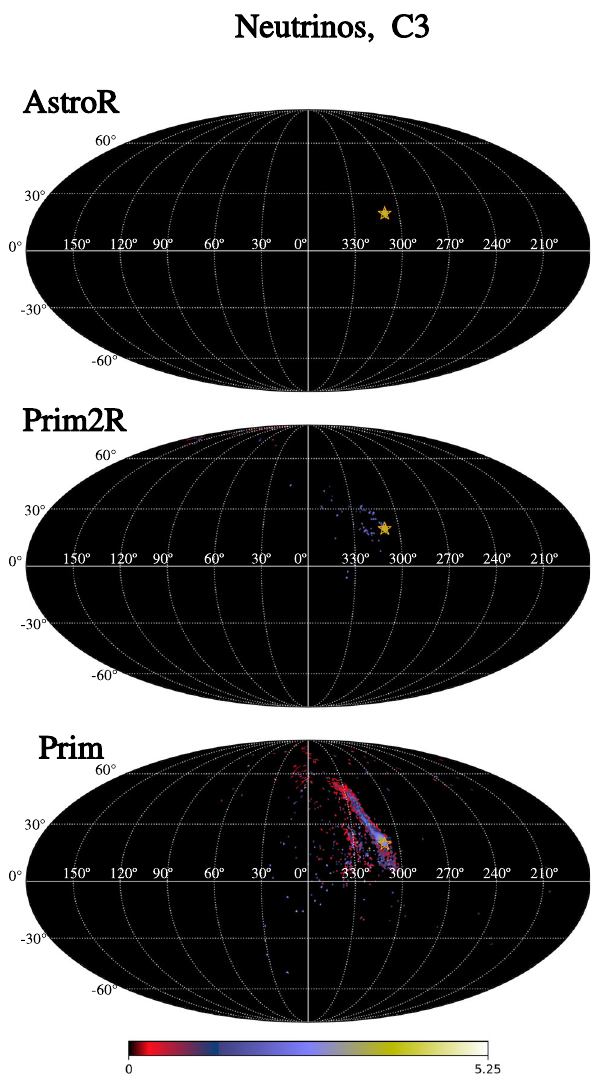
Fig. 5 Arrival direction map of secondary neutrinos for the three EGMF models and C3 composition abundance. The star indicates the position of Cen A. The maps are in galactic coordinates and Mollweide